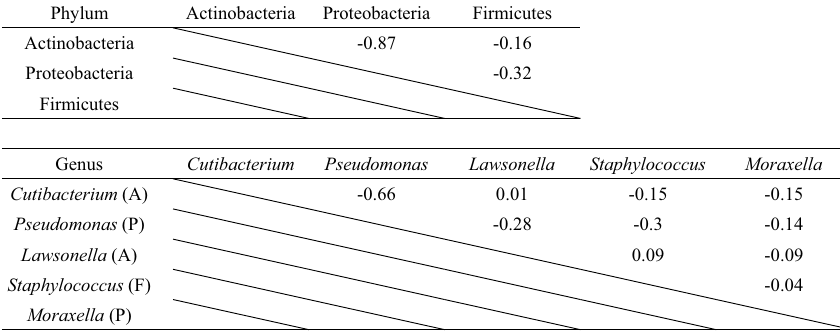
Table 1. Correlation analysis of relative abundance between major bacterial phyla and genera. These figures show correlation coefficient. (A): phylum Actinobacteria, (P): phylum Proteobacteria, (F): phylum